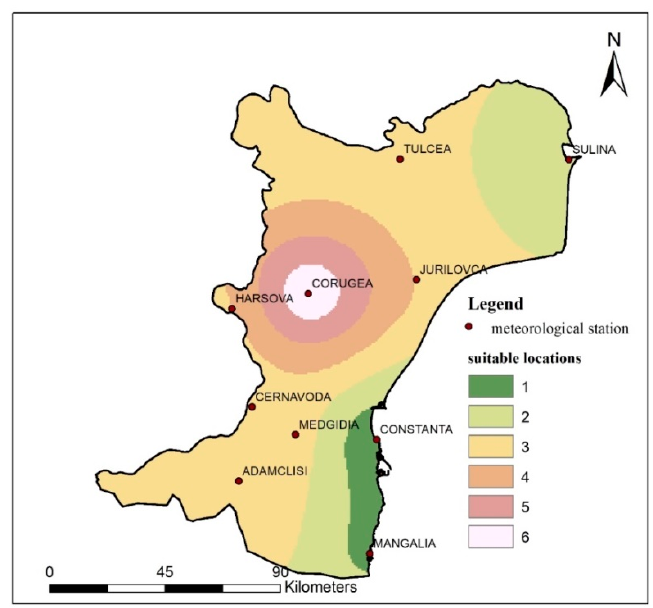
Figure 8. Suitable locations of Ae. albopictus establishment. 327